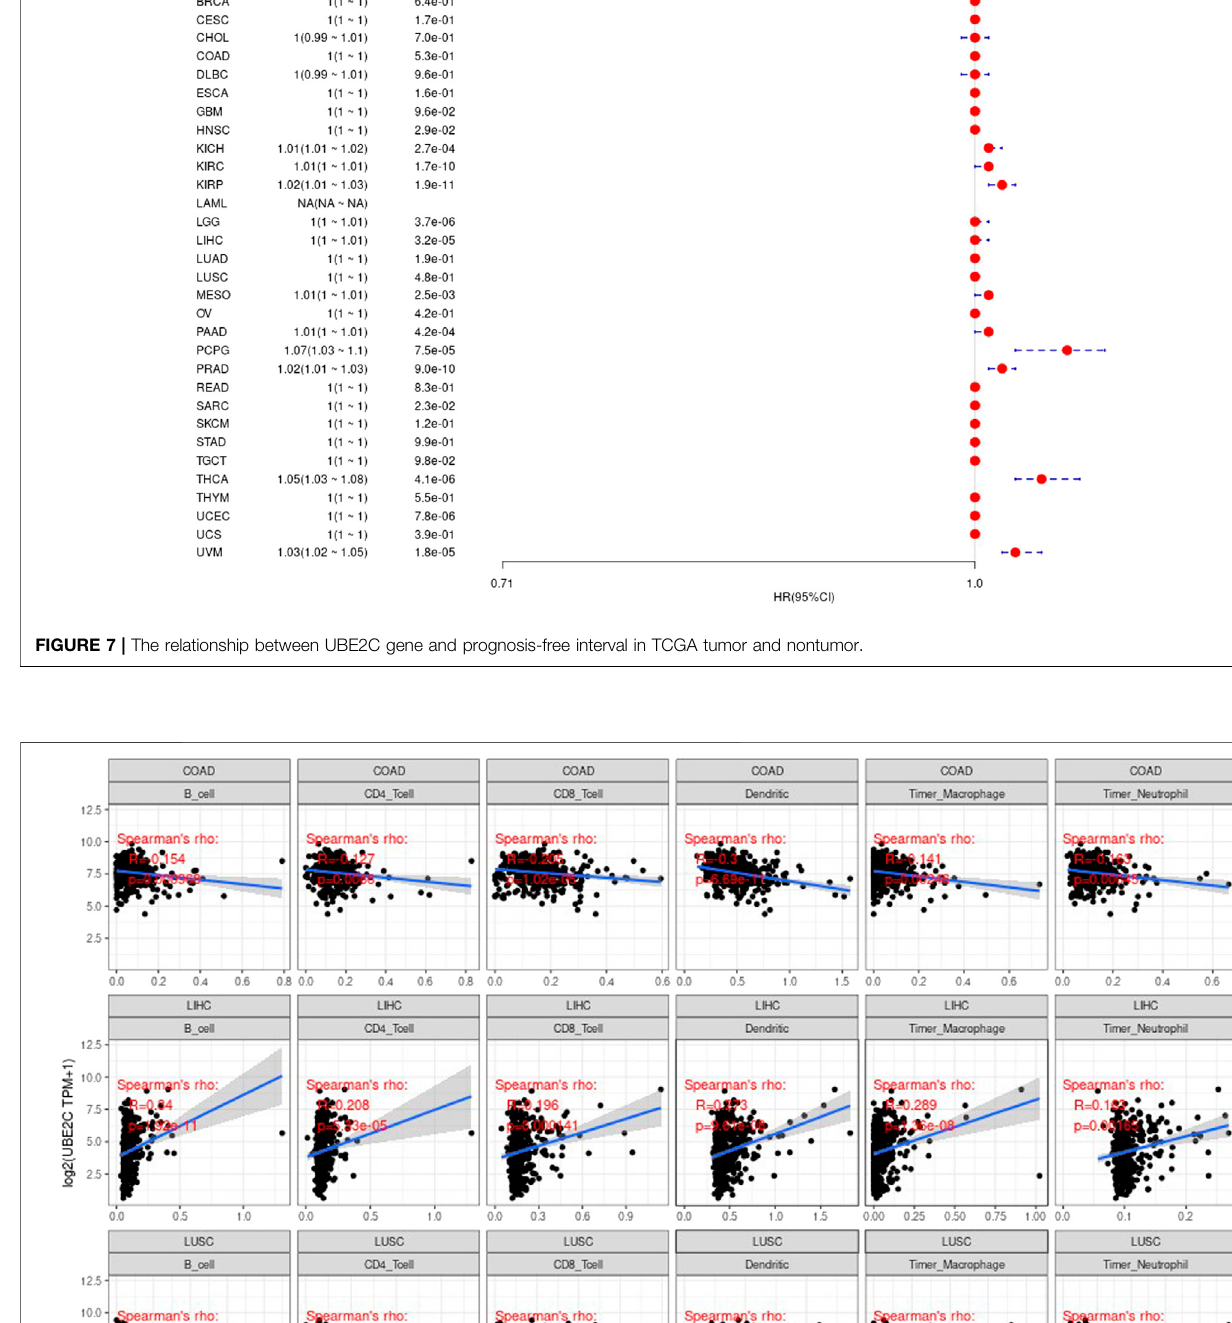
Frontiers in Genetics |